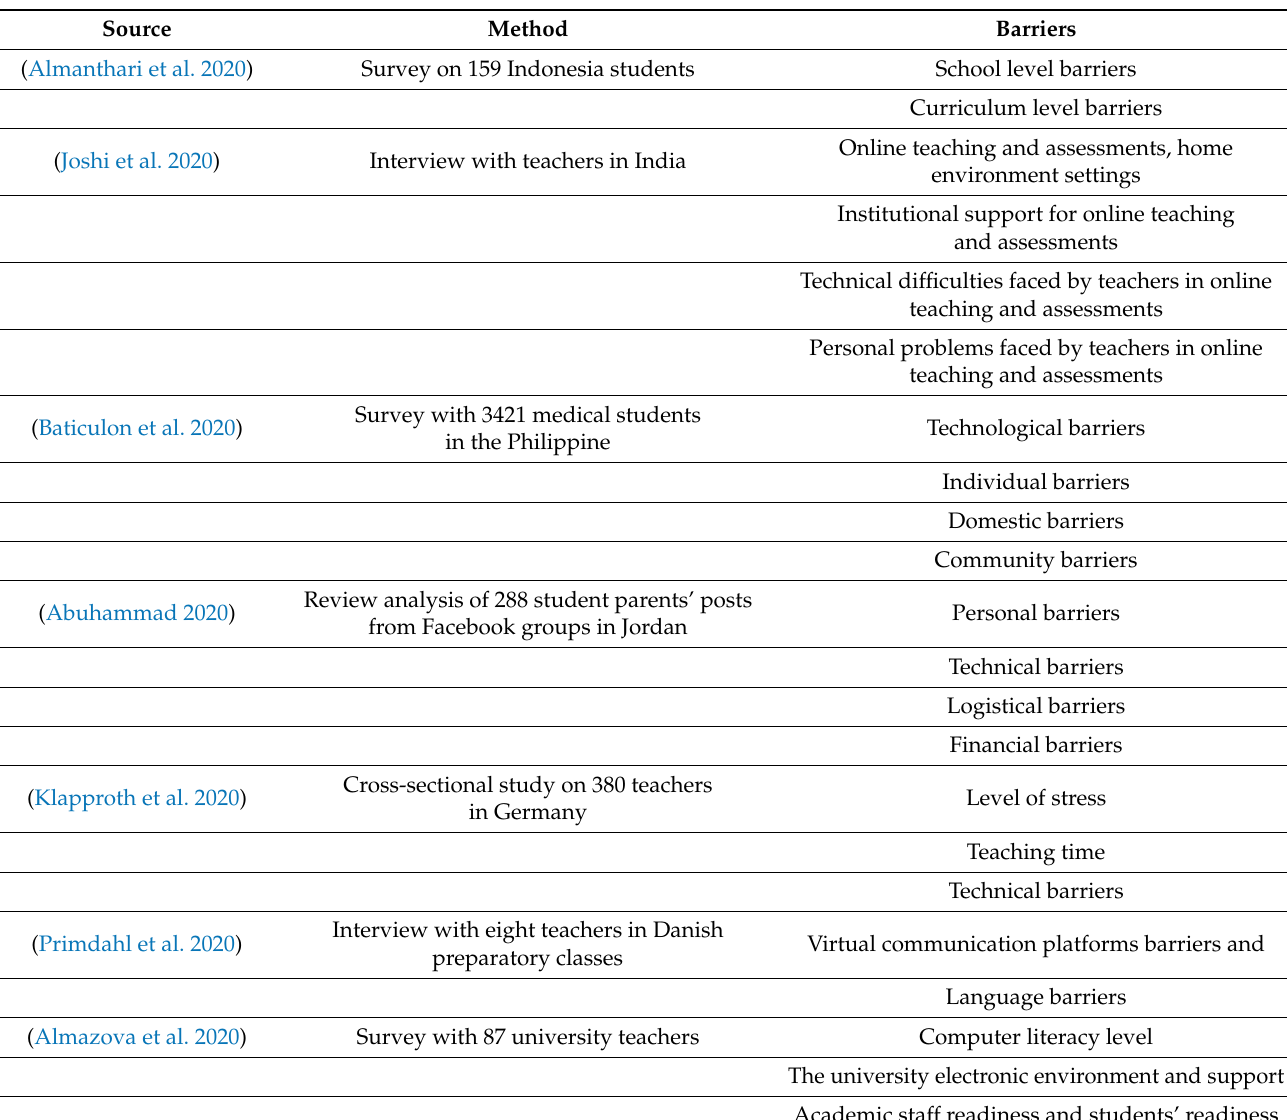
Table 1. Prior studies reporting barriers in education during